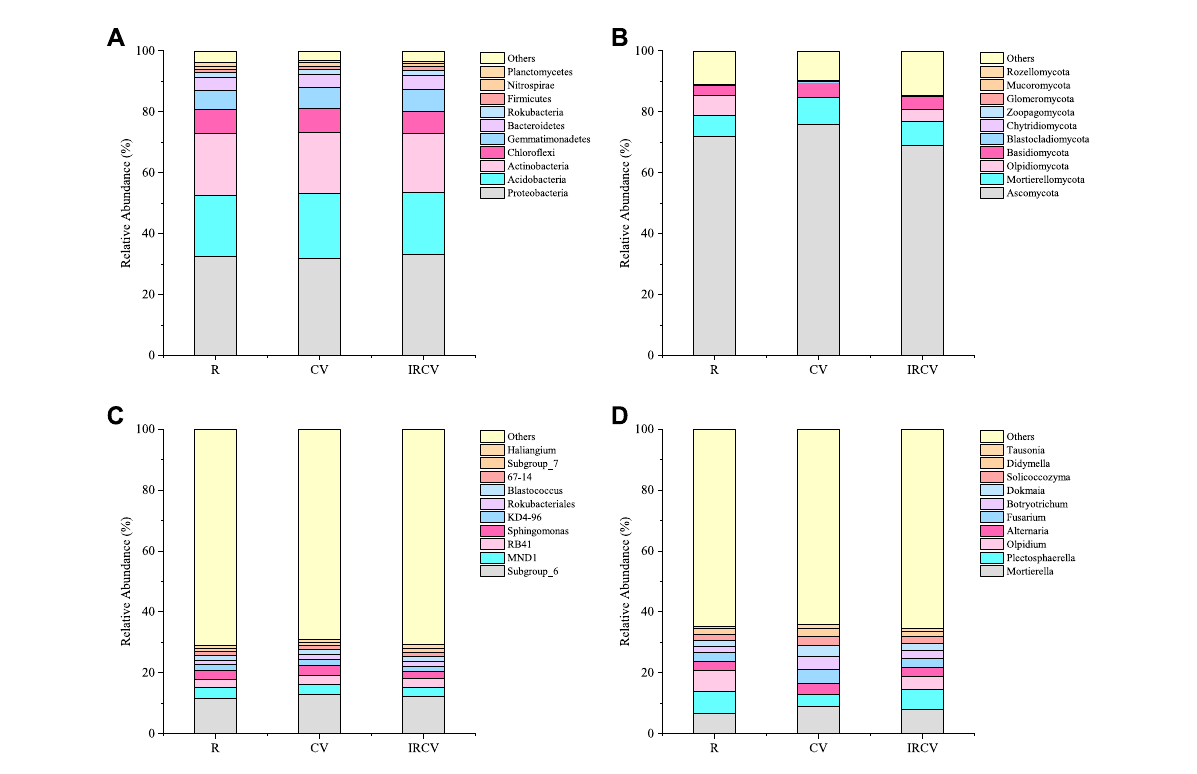
FIGURE 5 Relative abundances of the dominant bacteria [ (A) , at phylum level; (C) , at genus level] and fungi [ (B) , at phylum level; (D) , at genus level] in the threecroppingpatterns.Thetoptendominantphylaandgeneraofbacteriaandfungi,respectively,wereusedintheanalysis.Therelativeabundance ofeachphylumorgenuswascalculatedbytheaveragerelativeabundanceofthisphylumorgenusacrossallsoilsdividedbytheaveragetotalrelative abundance of all phyla in each cropping sequence. CV, R, and IRCV represent common vetch monoculture, rape monoculture, and R and CV intercropping,